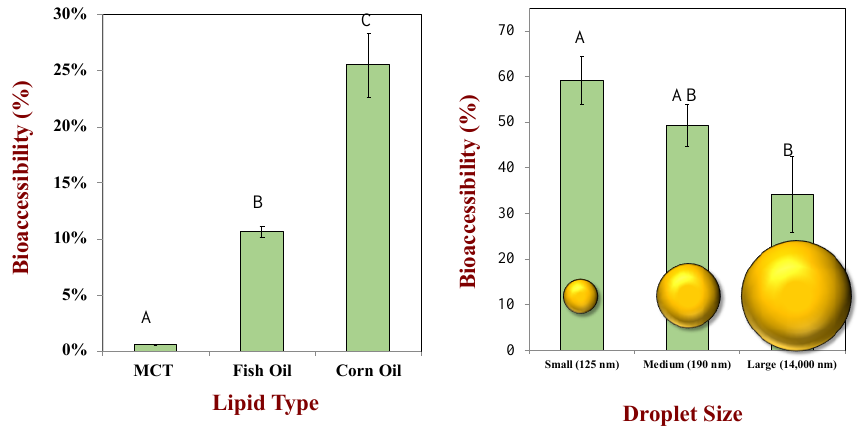
Figure 8. Impact of lipid type and oil droplet size on the extent of lipid digestion (%FFA) and β -carotene bioaccessibility from oil-in-water emulsions. Mean droplet diameters shown in nm. The letters above the bioaccessibility data show significant differences ( p < 0.05). Adapted from Salvia–Trujillo et al. [92,97].